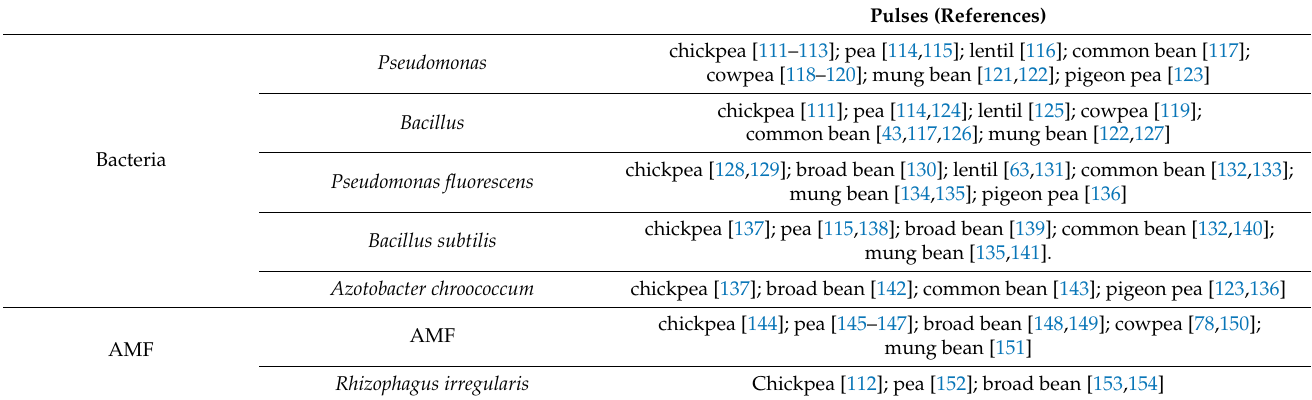
Table 2. Main microbial taxa described in interactions with pulses selected for their PGPR